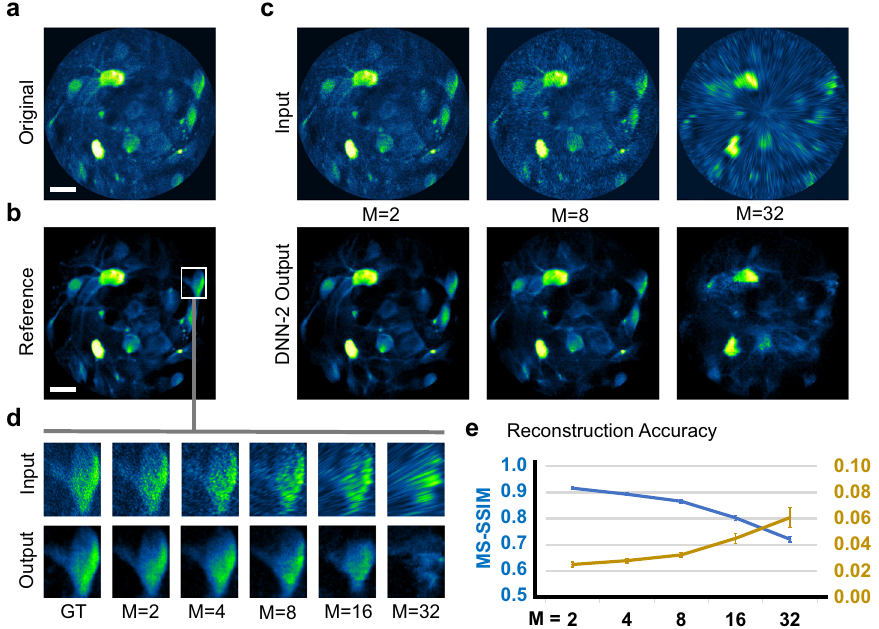
Fig. 3 Performance of DNN-2 for resolution recovery for in vivo head- fi xed 2 P images acquired at various scanning densities (from 512 spirals/frame to 512/M spirals/frame, M = 2 – 32). Each scanning density requires a separately trained network. a Representative original image (with a scanning density of 512 spirals/frame) and b the corresponding DNN-1 output image which served as the reference for quantitative image quality comparison. c Top-row: in vivo images of a lower scanning density as the input for testing DNN-2. These images were obtained by digitally down-sampling the original image by a factor of M along the radial direction; bottom-row: DNN-2 output images. d Structural details of a selected region of interest with respect to different M factors. e Reconstruction accuracy in terms of the multi-scale structure similarity (MS-SSIM) index and normalized root-mean-square error (NRMSE) for the entire testing image set with respect to the down-sampling factor M. The data are presented as mean values (data points) ± standard deviations (error bars). The measurements were made over the whole image stack with a total number of images n = 800. Scale bars in ( a , b ): 20 µ